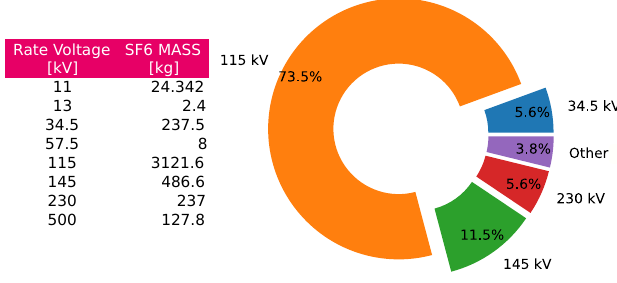
Figure 2. Distribution of SF 6 mass based on ENEL-CODENSA assets data.